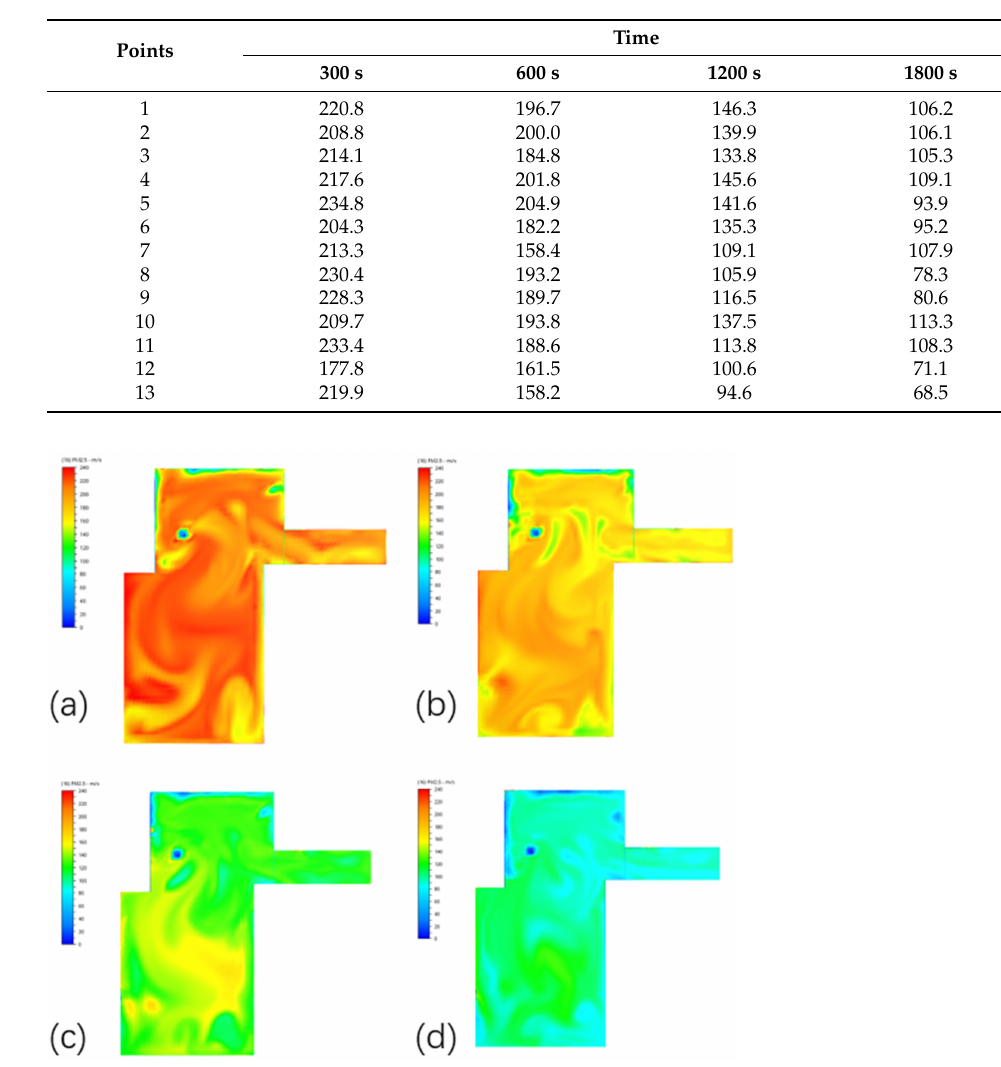
Figure A2. The simulation results of case 2 at the time of ( a ) 300 s; ( b ) 600 s; ( c ) 1200 s; ( d ) 1800 s. Table A2. Quantitative results of case 2.